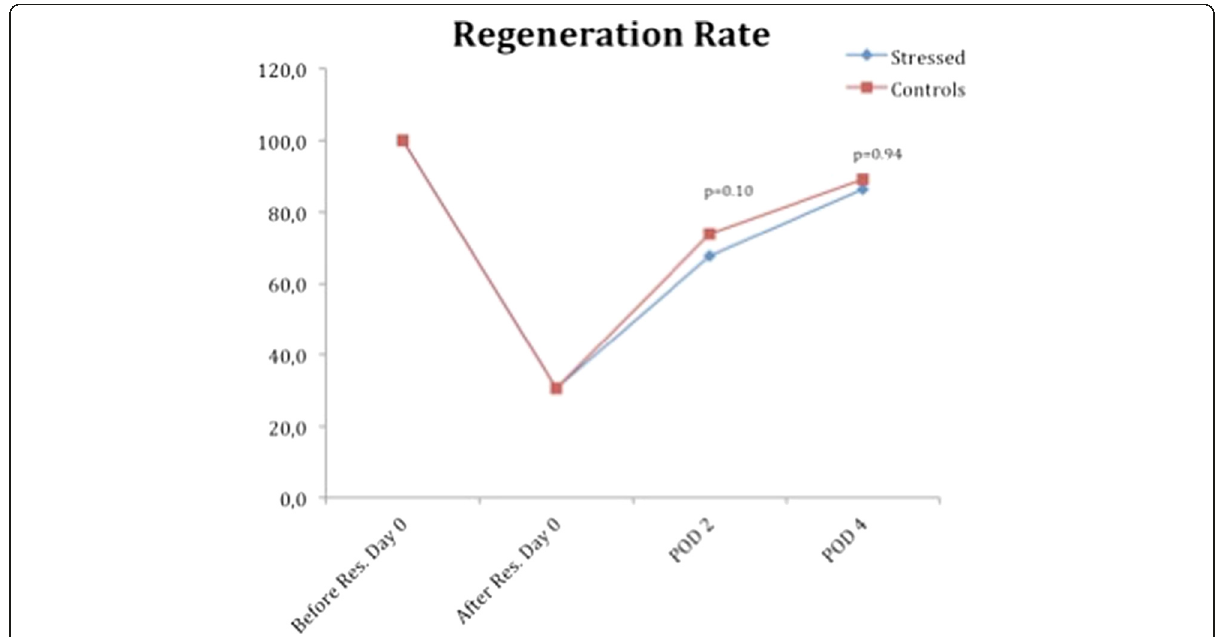
Fig. 5 Regeneration Rate. Mean regeneration rate for each group of animals. The blue line marks the treatment group and the red line marks the control